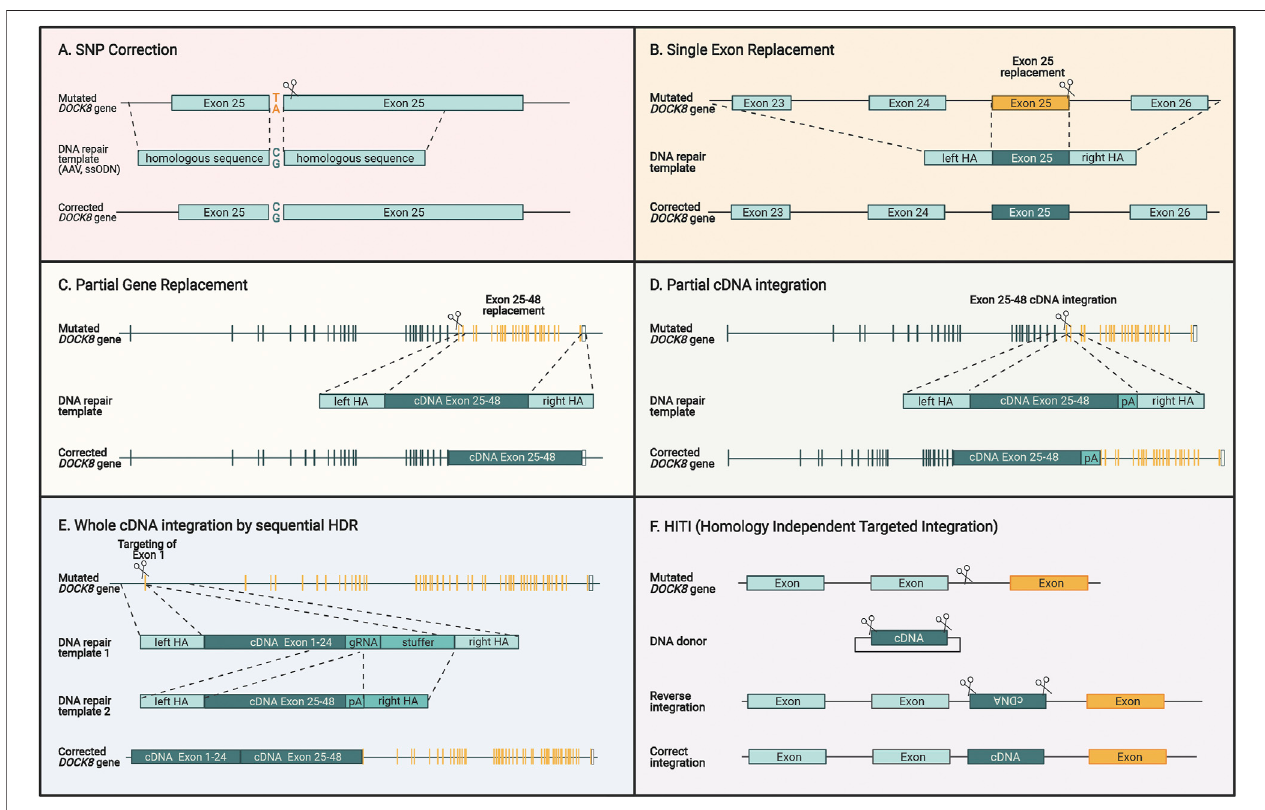
FIGURE 5 | Different genome editing strategies for restoring DOCK8 gene expression. (A) Speci fi c correction of SNPs by providing DNA repair templates with homologous sequences surrounding the mutation. (B) Single exons can be replaced by introducing a double strand break close to the end of the exon in addition to supplying a DNA repair template encoding homologous sequences surrounding the exon. (C) Multiple exons can be replaced by cutting close to the region which is intended to be replaced and providing a DNA repair template with homology arms that are homologous to the adjacent regions. (D) A cDNA sequence covering severalexonscan be introduced upstream tothe mutated sequence and the homology arms contain the sequences surrounding the cut site. This way the cDNA will be fused directly to the previous exons, and the downstream exon will be inactivated. (E) To replace the entire DOCK reading frame, a two-step HDR approach can be applied due. For utilizing AAV vectors for repair template delivery, this two-step approach is necessary due to the large size of the gene and the limited capacity of AAV vectors. (F) HITI is different to the previous HDR-based strategies since it uses the NHEJ pathway to insert a DNA sequence without homology arms directly at the cut site. Since this insertion is not exact, intronic regions are targeted to insert a desired sequence that maintains the normal splicing mechanisms and keeps endogenous expression intact. For all fi gures, the yellow sequences designate exons where patient mutations will be corrected by the speci fi c approach.